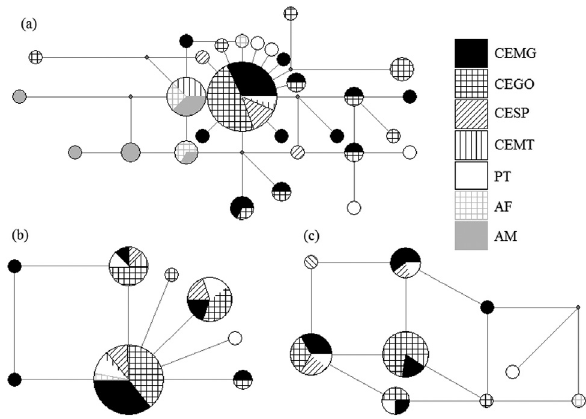
Figure 2 - Median-joining networks of M. tridactyla haplotypes. (a) mtDNA,HVIandCyt-b;(b)nDNA, RAG2; (c)nDNA,iAMELY.Sizesof circles are proportional to the amount of individuals carrying the haplo- type. Colors and patterns are representative of populations from which in- dividuals originated (depicted in labels).